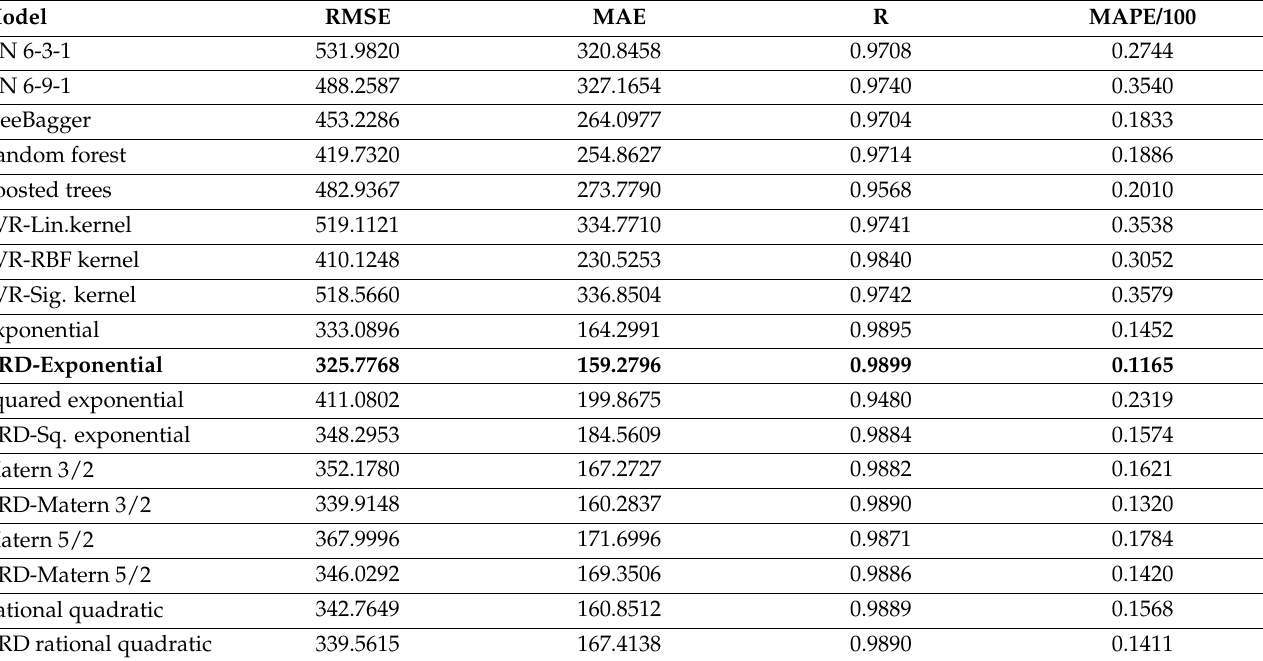
Table 4. Accuracy of analyzed machine learning models in accordance with the defined